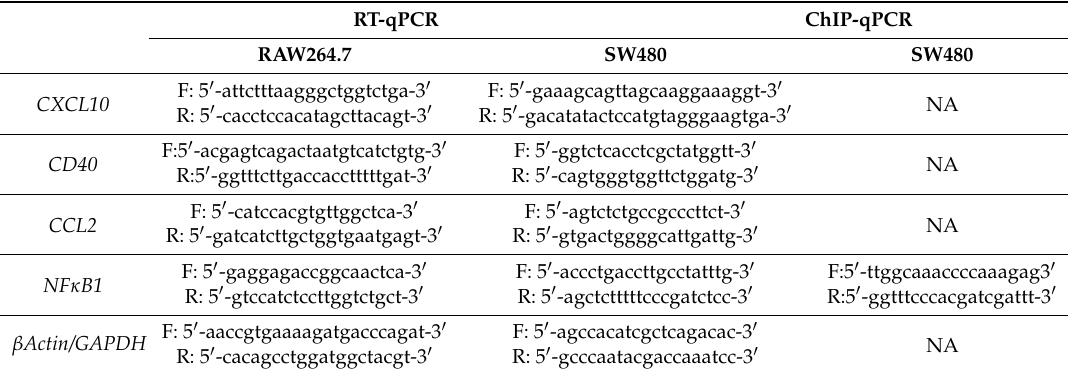
Table 3. Primer sequences used in the